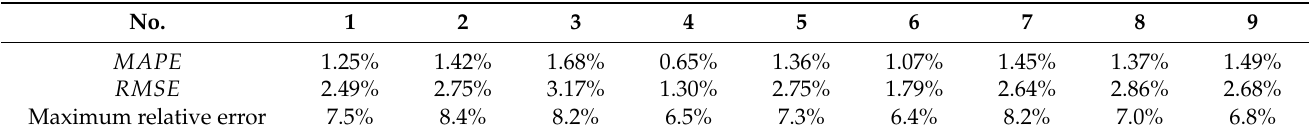
Table 12. Calculation results of cross-validation.